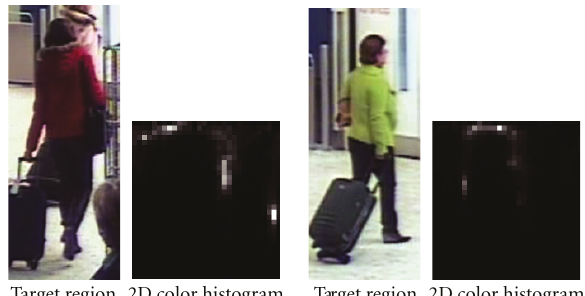
Figure 10: Target regions and 2D color